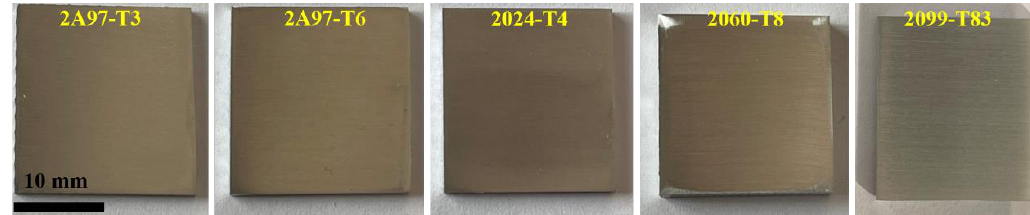
Figure 1. The macroscopic morphology of the sample before soaking.